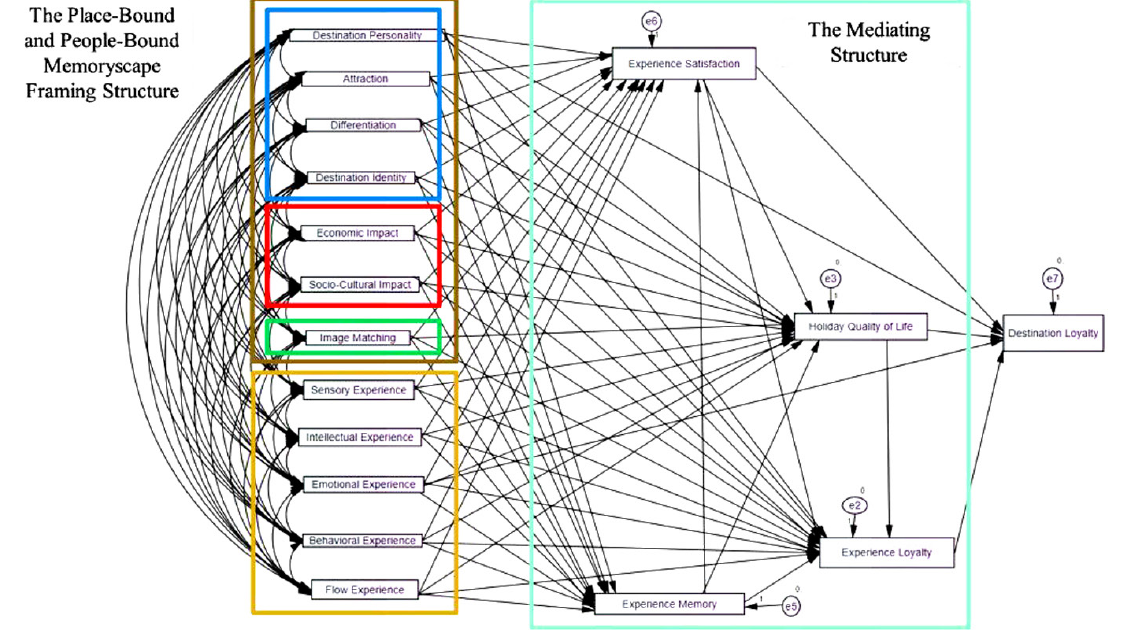
Figure 1. Conceptual